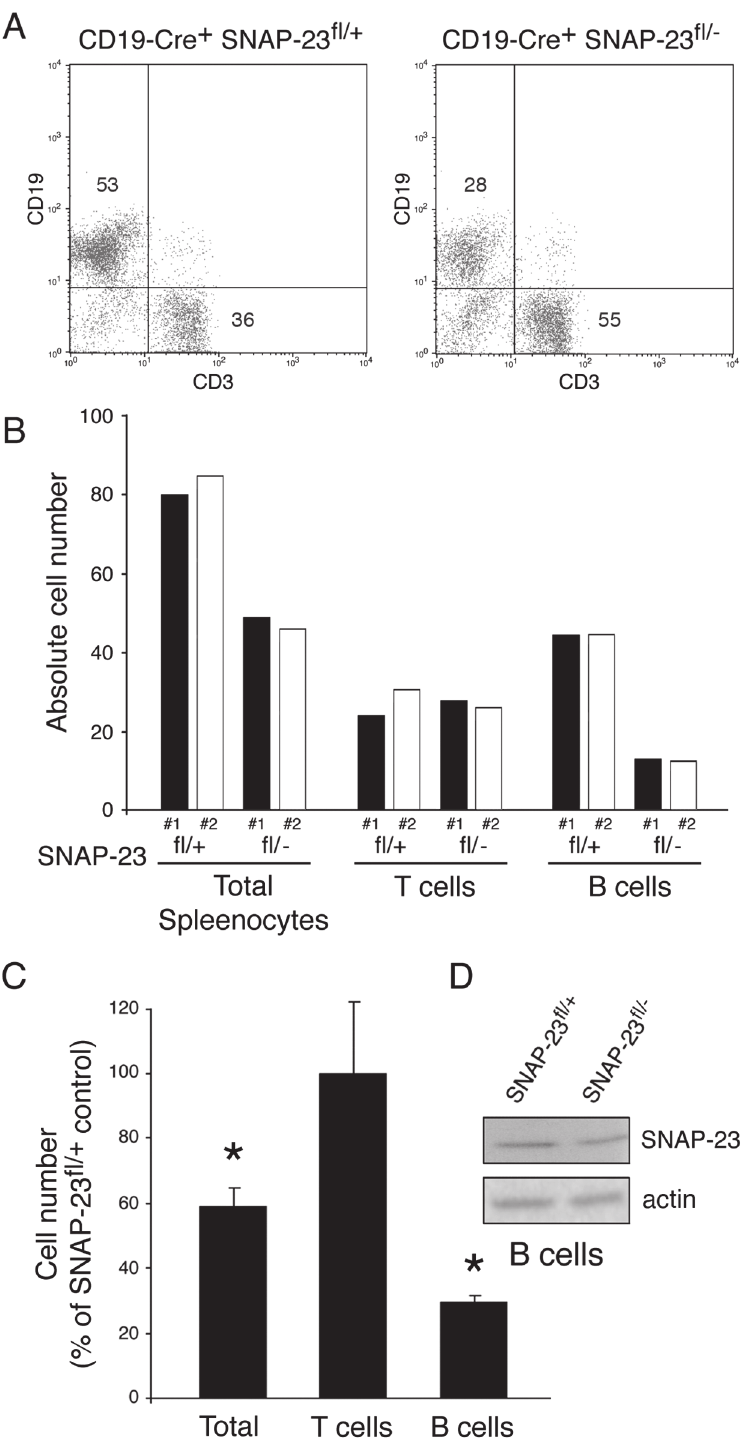
Fig 2. SNAP-23 is essential for B cell survival. Spleens were harvested from CD19-Cre + SNAP-23 fl/+ control mice or CD19-Cre + SNAP-23 fl/- mice (line E3) and single cell suspensions were stained with fluorochrome-conjugated CD19- and CD3-mAb and analyzed by flow cytometry. (A) A representative flow cytometry profile reveals a dramatic reduction in the percentage of CD19 + B cells in the spleen. (B) Quantitative analysis of two different matched pairs of CD19-Cre + SNAP-23 fl/+ or SNAP-23 fl/- littermate mice indicating total spleen cell numbers as well as the numbers of T cells (CD3 + cells) and B cells (CD19 +